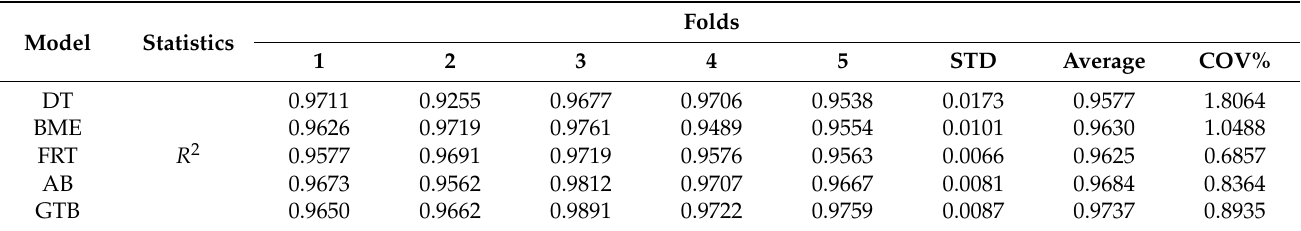
Table 5. Cross-validation measurement results.